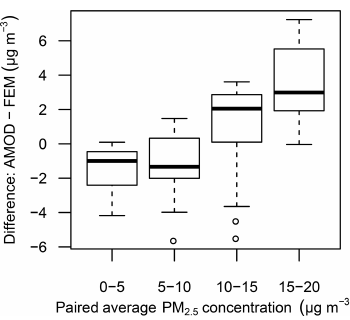
Figure 5. Binned paired average PM 2 . 5 concentration vs. paired difference AMOD and FEM PM 2 . 5 measurements. Measurement pairs ( n = 96) consist of AMOD and FEM measurements that are temporally and spatially coincident. The four size bins (up- per bound inclusive) are 0–5µgm − 3 ( n = 30), 5–10µgm − 3 ( n = 24), 10–15µgm − 3 ( n = 30), and 15–20µgm − 3 ( n = 12). All light- scattering AMOD measurements include the proprietary PMS5003 atmospheric correction and are further corrected to the correspond- ing AMOD filter